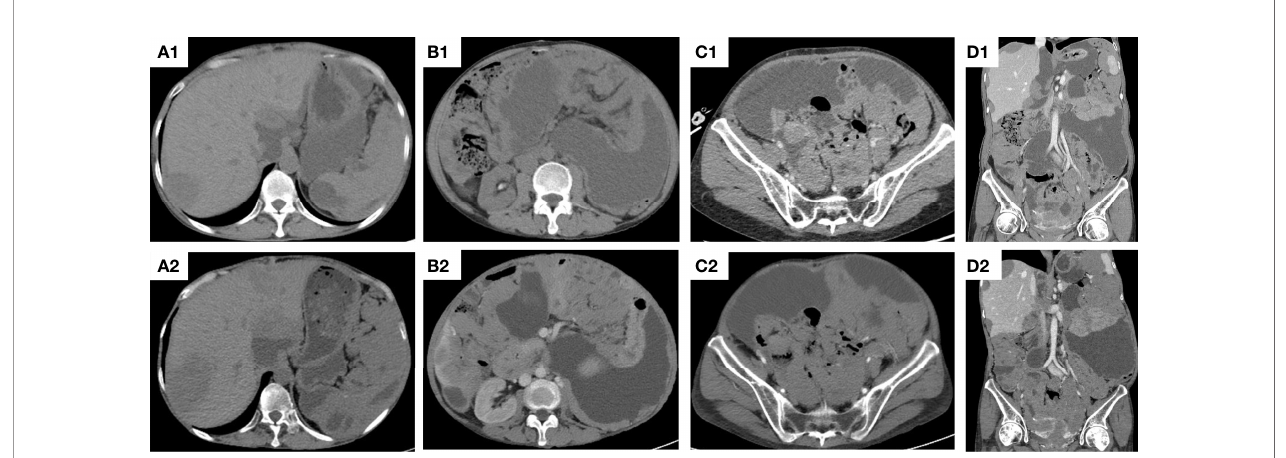
FIGURE 5 | The computed tomography (CT) of the patient. (A1) Upper abdominal CT scan before apatinib treatment; (A2) Upper abdominal CT scan after apatinib treatment for 3 years; (B1) Lower abdominal CT scan before apatinib treatment; (B2) Lower abdominal (CT) scan after apatinib treatment for 3 years; (C1) Pelvic CT scan before apatinib treatment; (C2) Pelvic CT scan after apatinib treatment for 3 years; (D1) Coronal CT scan before apatinib treatment; (D2) Coronal CT scan after apatinib treatment for 3